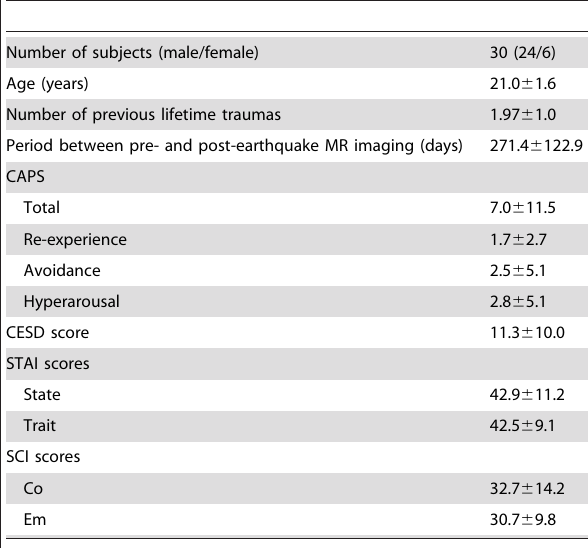
Table 1. Demographic characteristics of the non-PTSD survivors.